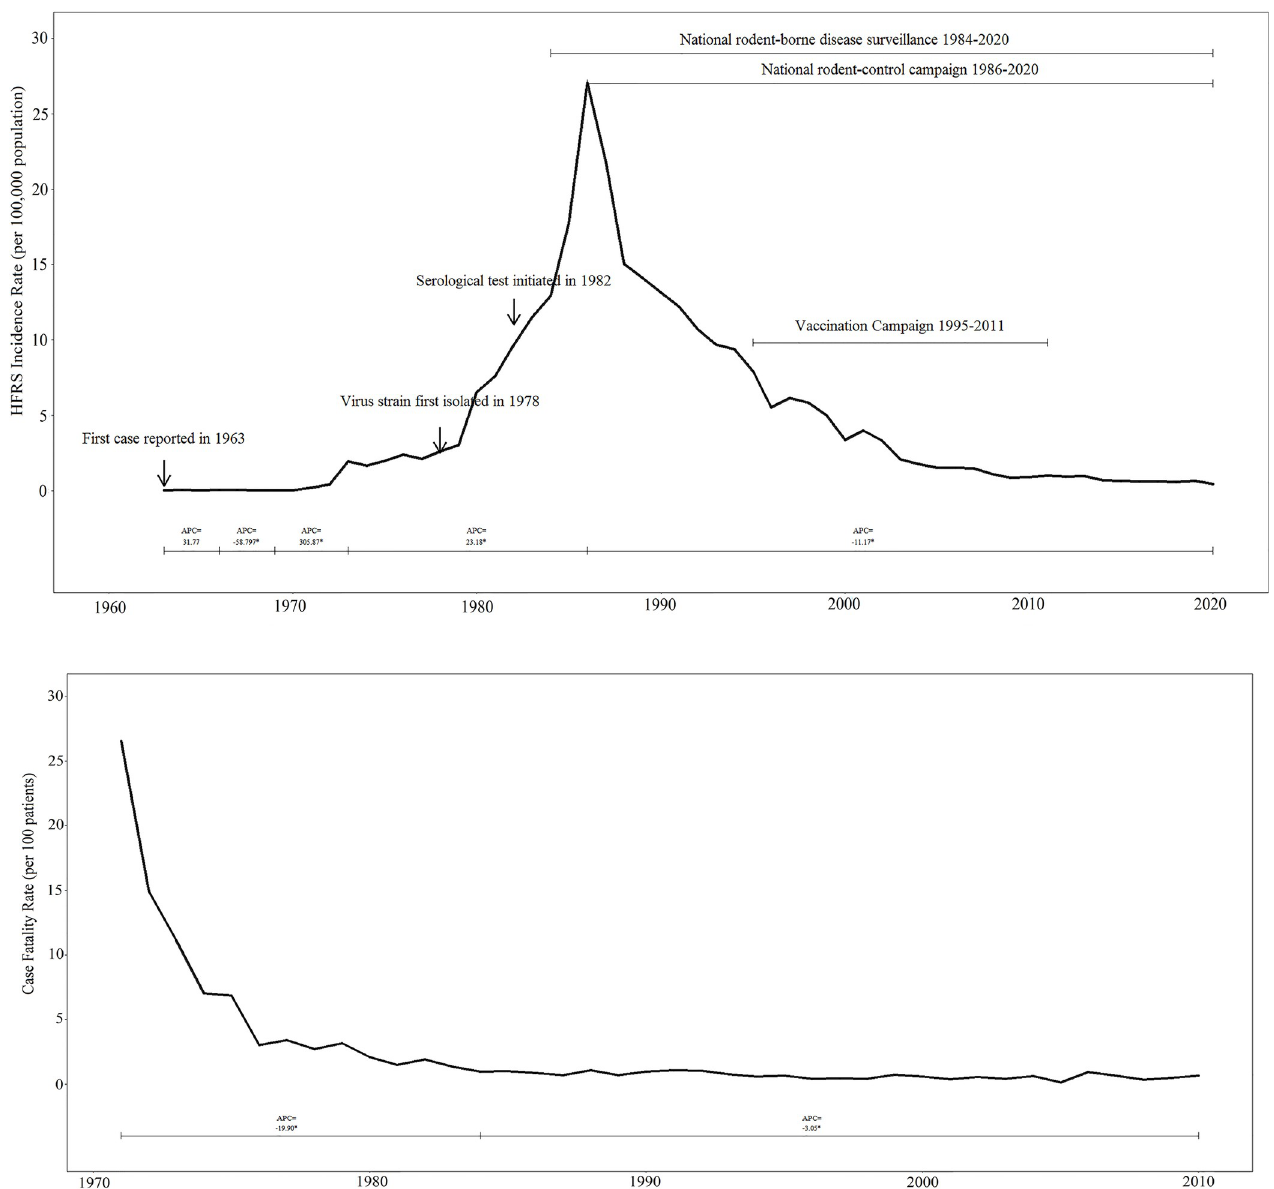
Fig 1. The incidence and case-fatality rate of HFRS in Zhejiang Province, 1963–2020,